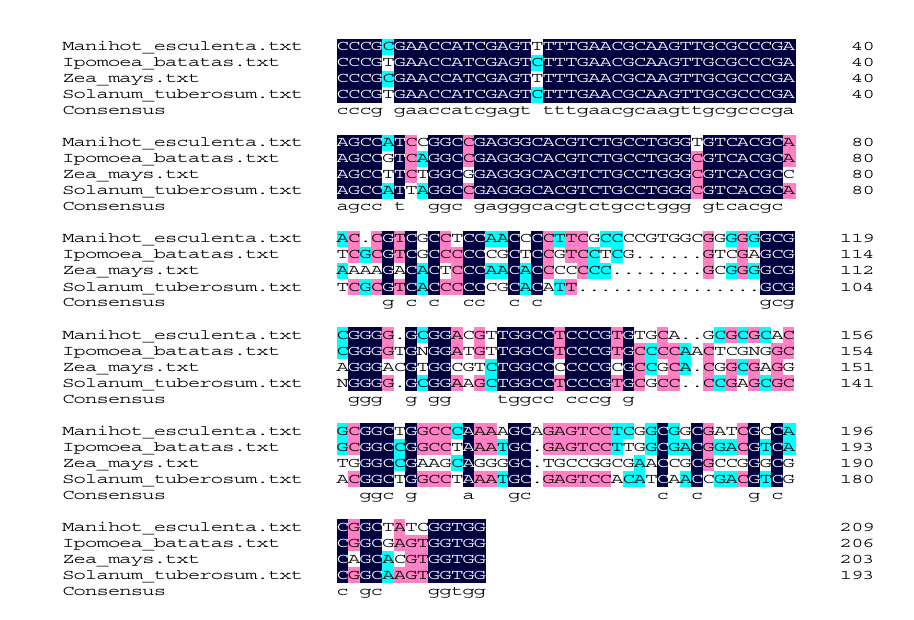
Figure 1. The alignment of the target sequences from Manihot esculenta with the corresponding sequences of Ipomoea batatas , Zea mays , and Solanum tuberosum